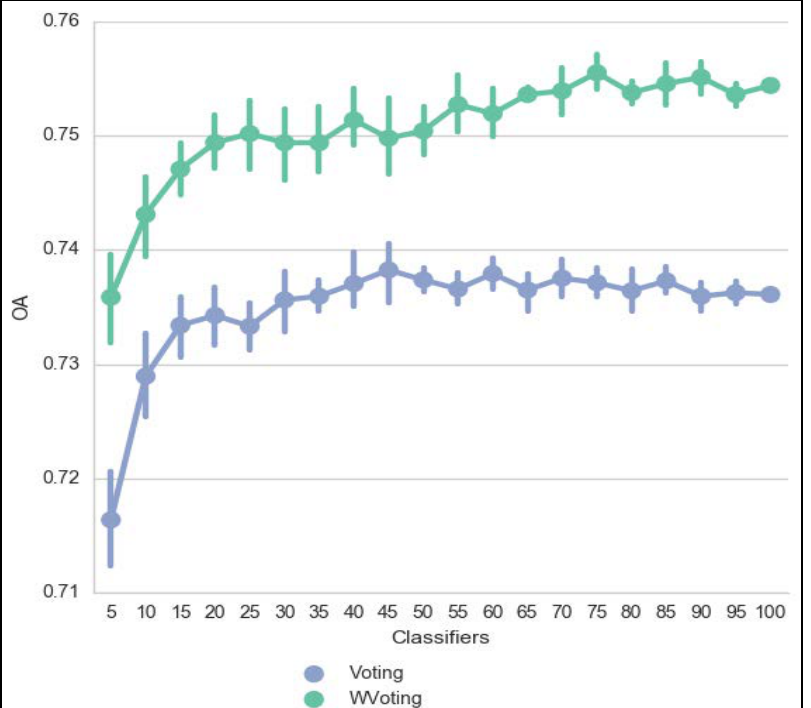
Figure 7. Mean and standard deviation of the overall accuracy using majority voting and weighted majority voting. majority